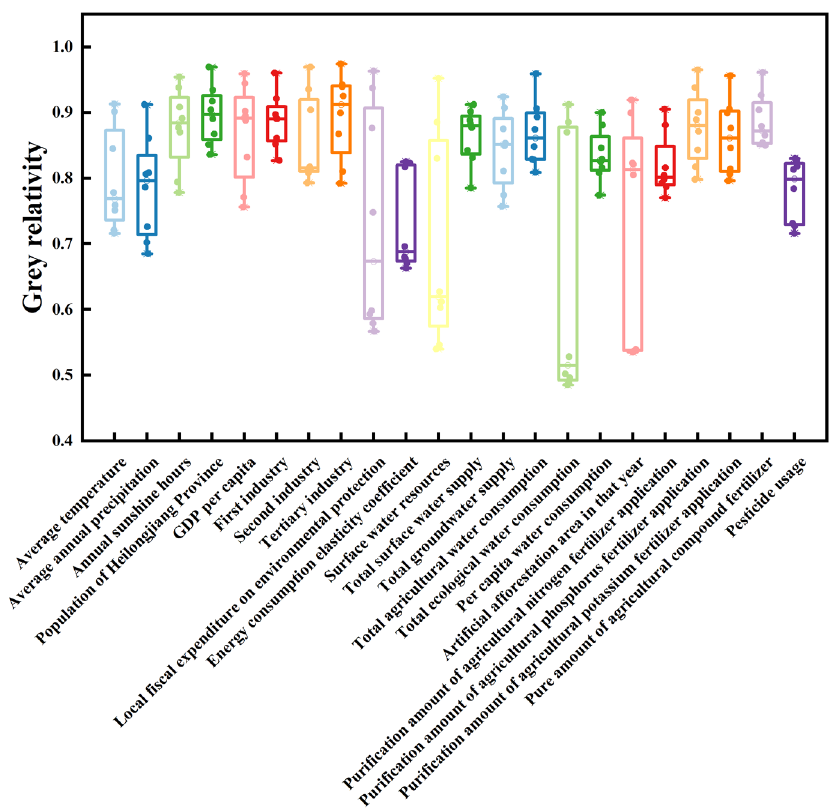
Figure 4. Statistical map of the correlation between each reference sequence and the environmental quality of surface water.